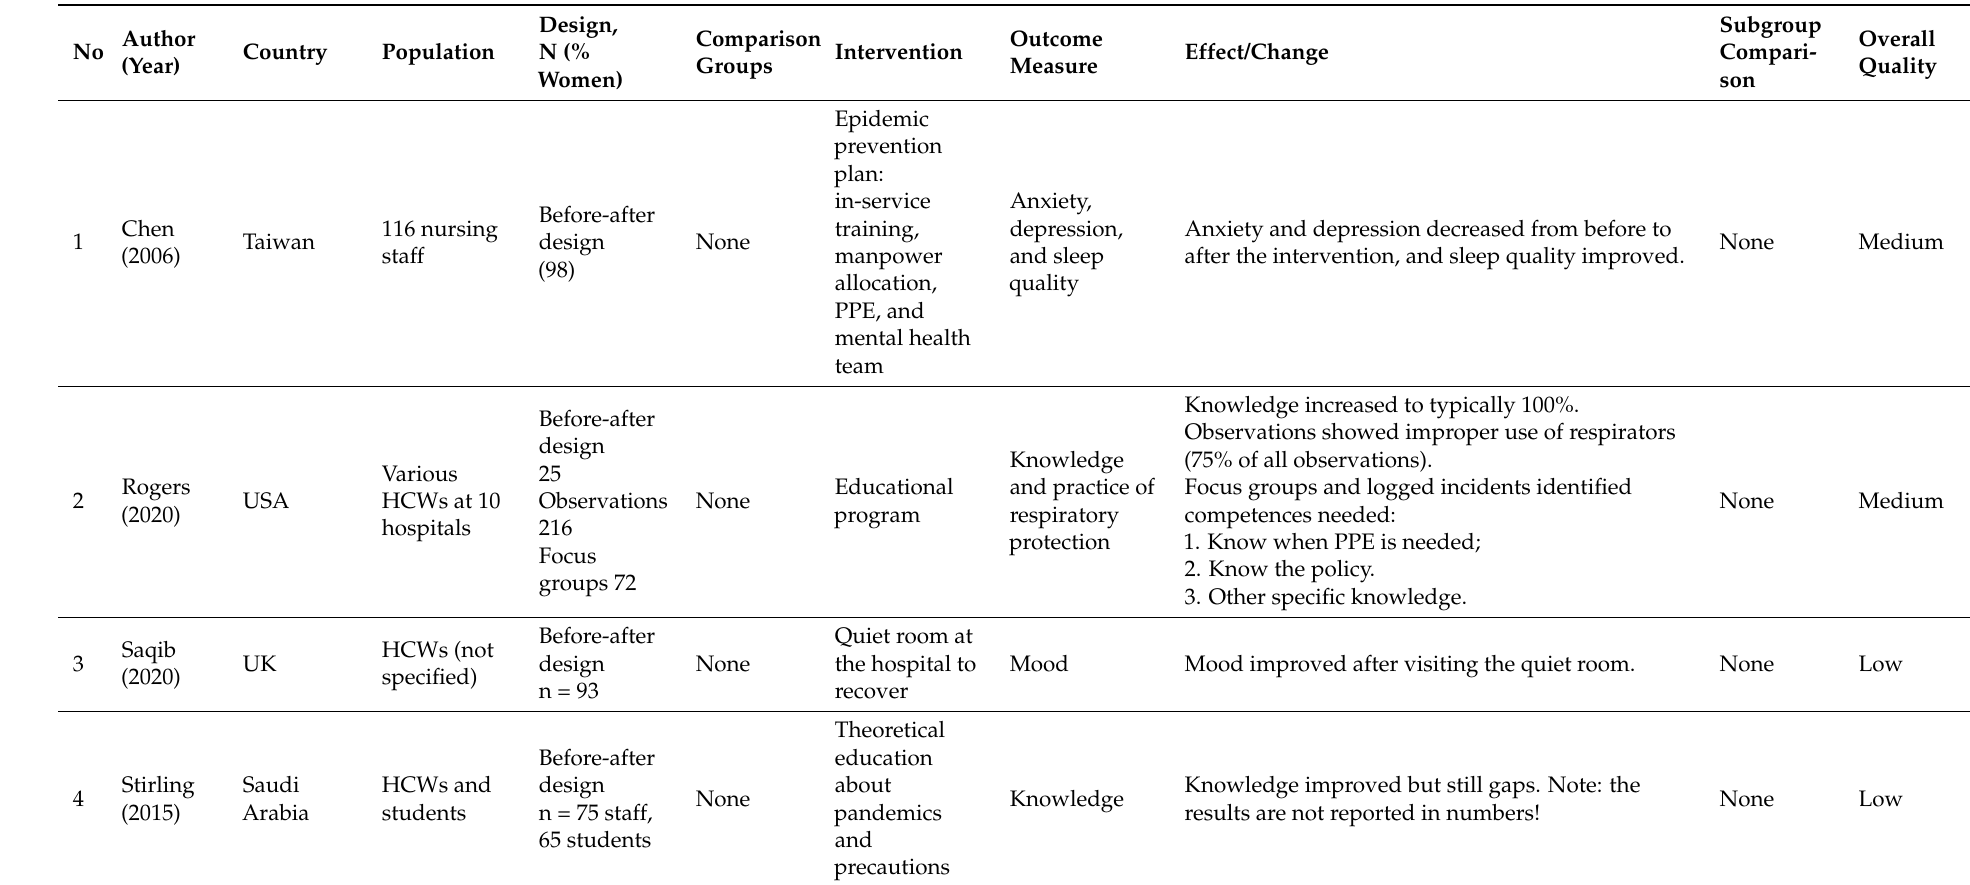
Table 3. Overview of quantitative studies assessing interventions to change the work environment or health in the healthcare industry during an epidemic or pandemic (COVID-19, SARS, or MERS, research question 3).